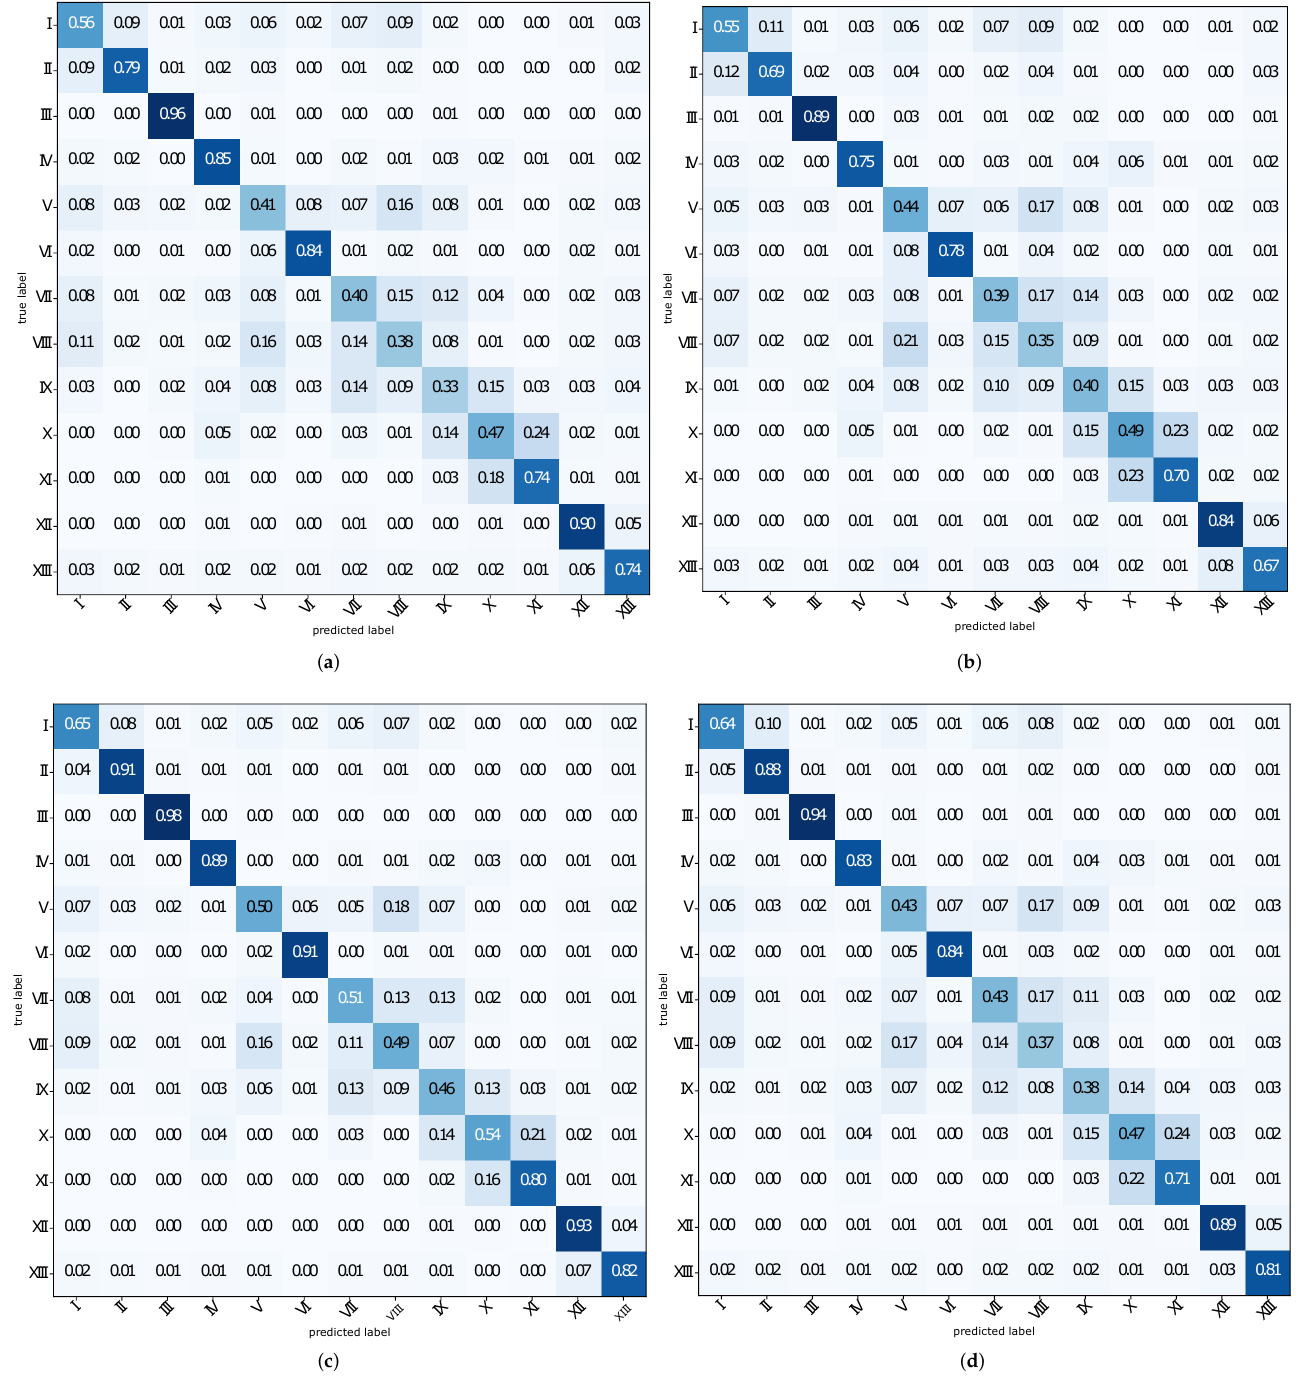
Figure 6. The confusion matrices of the four encoding in Experiment one : ( a ) GSCM; ( b ) LGSCM; ( c ) GSCM; ( d ) CUBE. Please note that in Experiment one all available OWL classes (all LoAs) were used. The horizontal and vertical axis indicates predicted vs.true labels,